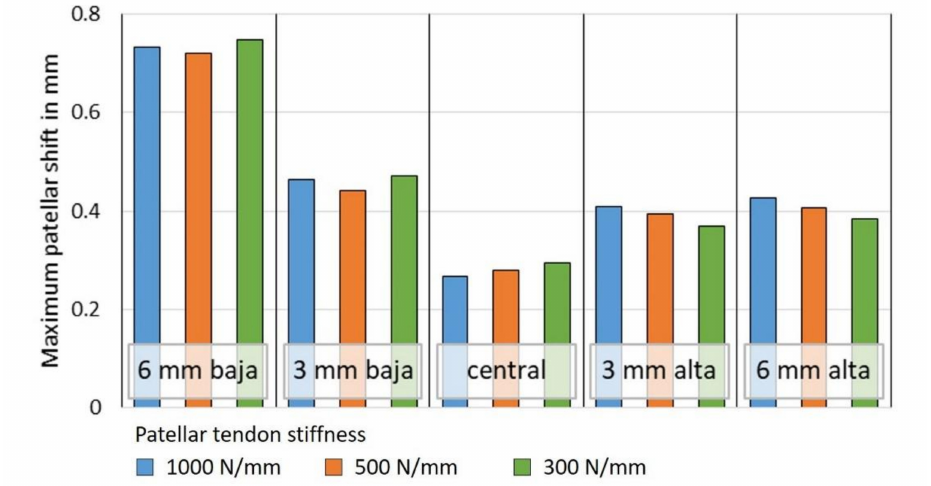
Figure 11. Peak values of the patellar shift during weight-bearing squat for several initial patellar positions (left to right: 6 mm baja to 6 mm alta) and patellar tendon stiffnesses (blue: 1000 N/mm, orange: 500 N/mm, and green: 300 N/mm). A positive patellar shift is given for relative patellar movements along the femoral mediolateral axis in lateral